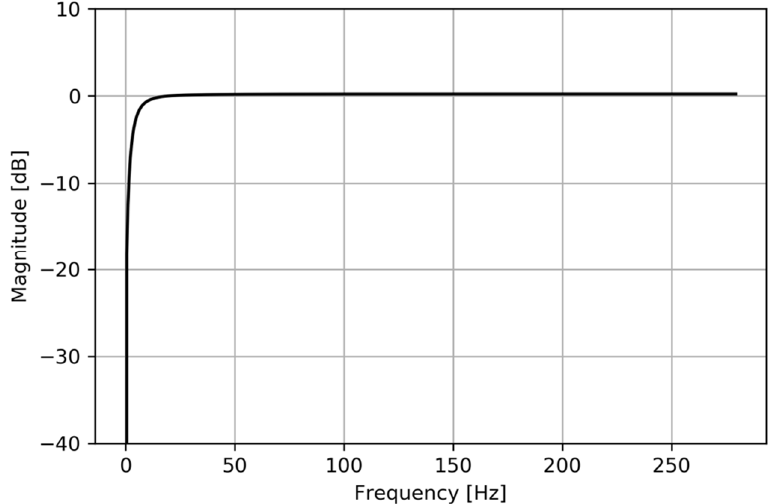
Figure 2. Frequency response of the infinite impulse response (IIR) filter designed for this application.